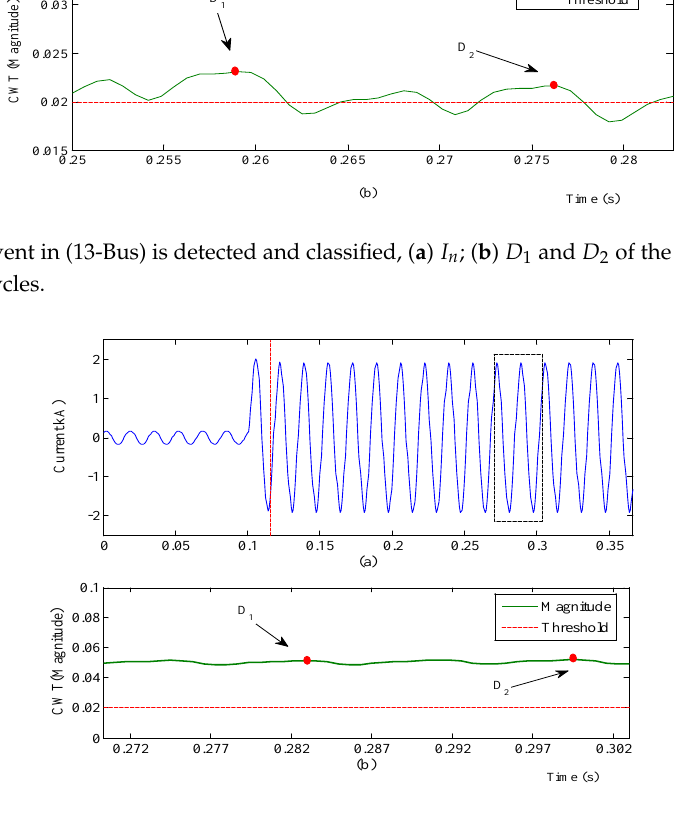
Figure 9. Sub-cycle IF event (130 Ω) in (13-Bus) is detected and classified, ( a ) 𝐼𝐼 𝑎𝑎 ; ( b ) 𝐷𝐷 3 ; ( c ) 𝐷𝐷 1 and 𝐷𝐷 2 of the normalized 𝐼𝐼 𝑛𝑛 in the 11th–12th cycles. Figure 10. Self-cleared CB restrike in (13-Bus) is detected and classified, ( a ) 𝐼𝐼 𝑏𝑏 and 𝐷𝐷 4 ; ( b ) 𝐷𝐷 3 ; ( c ) 𝐷𝐷 1 and 𝐷𝐷 2 of the normalized 𝐼𝐼 𝑛𝑛 in the 11th–12th cycles.